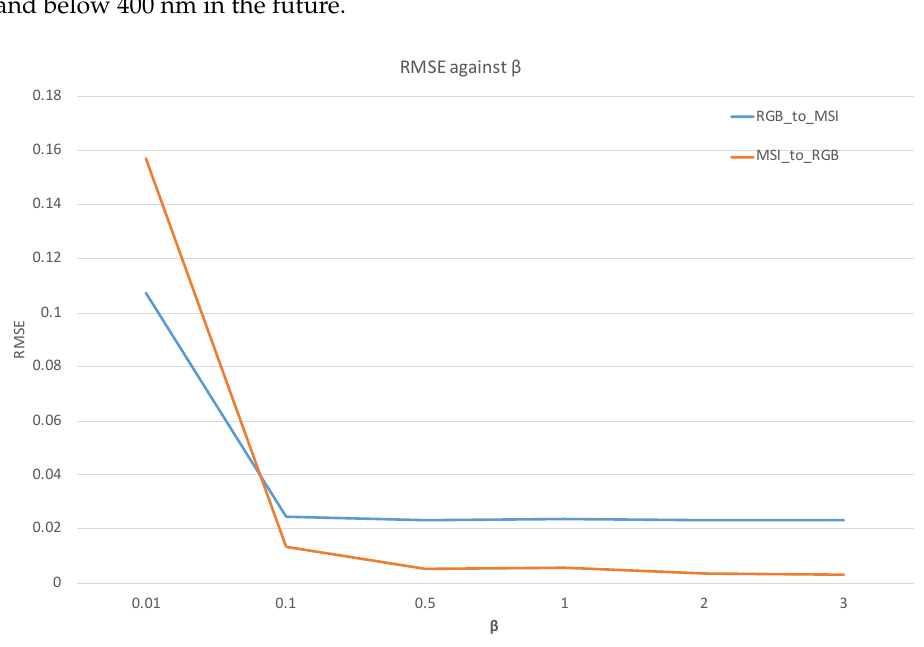
Figure 14. The RMSE against the β on the CAVE